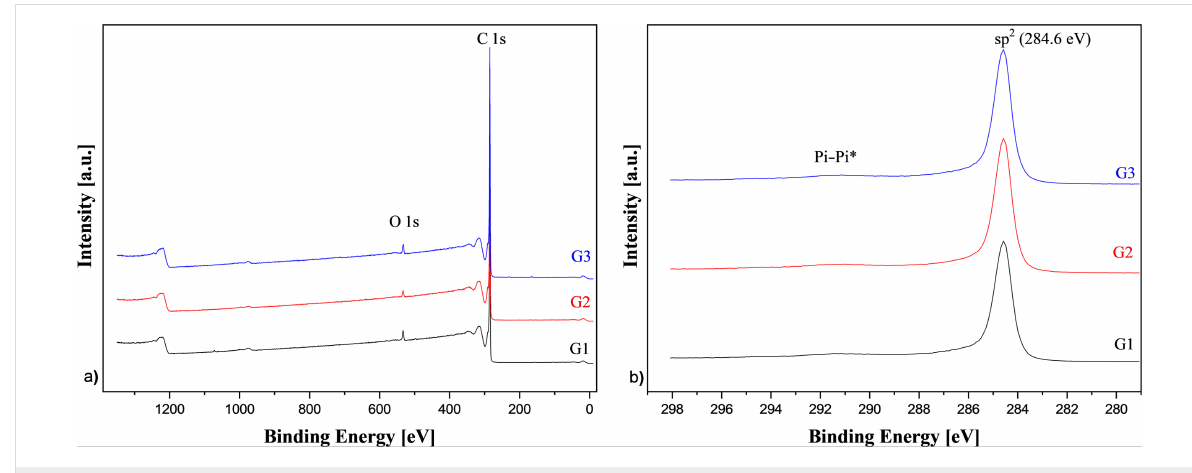
Figure 2: XPS: a) survey and b) C 1s high-resolution spectra for G1, G2, and G3.